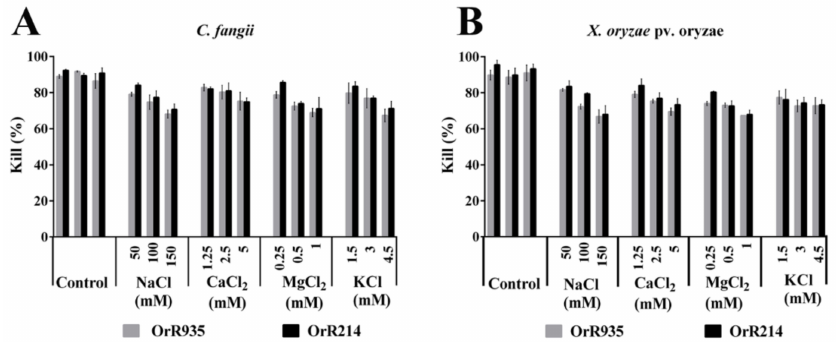
Figure8. Thee ff ectsofantimicrobialpeptidesundervariouscationicconcentrationsagainsttheindicator bacteria X. oryzae pv. oryzae ( A ) and ( B ) C. fangii . The control contained no salt. Three